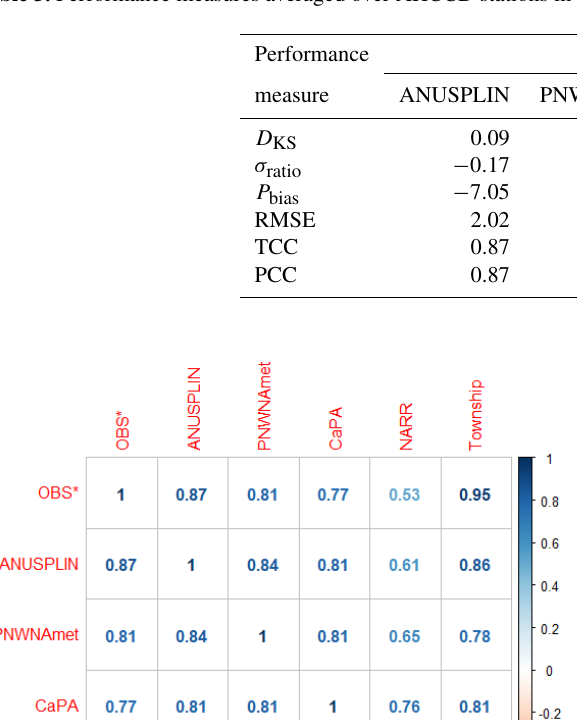
Table 3. Performance measures averaged over AHCCD stations in Alberta for precipitation.